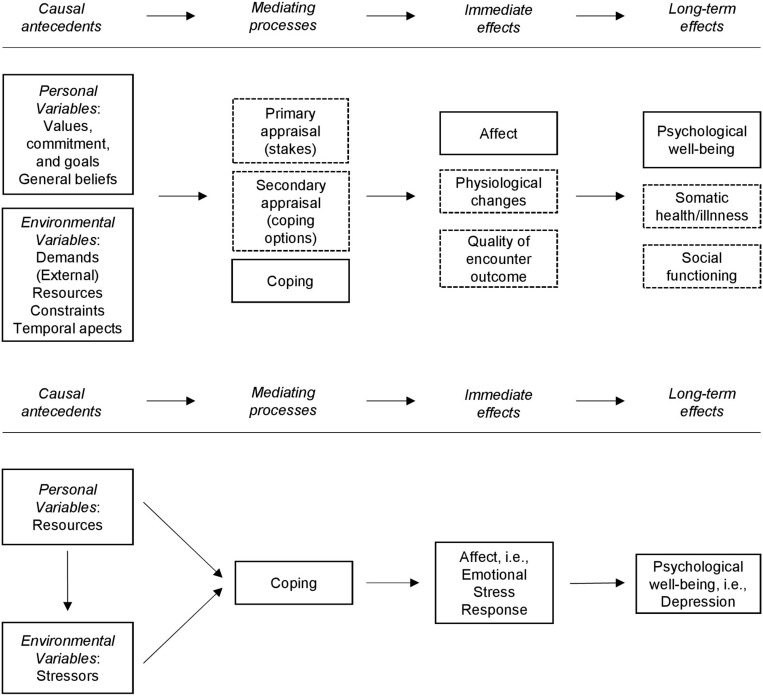
Transactional model by Lazarus and Folkman (1987). Dashed frames indicate parts of the models that were not tested in the present study. Bottom: parts of the model that were tested in the present study.